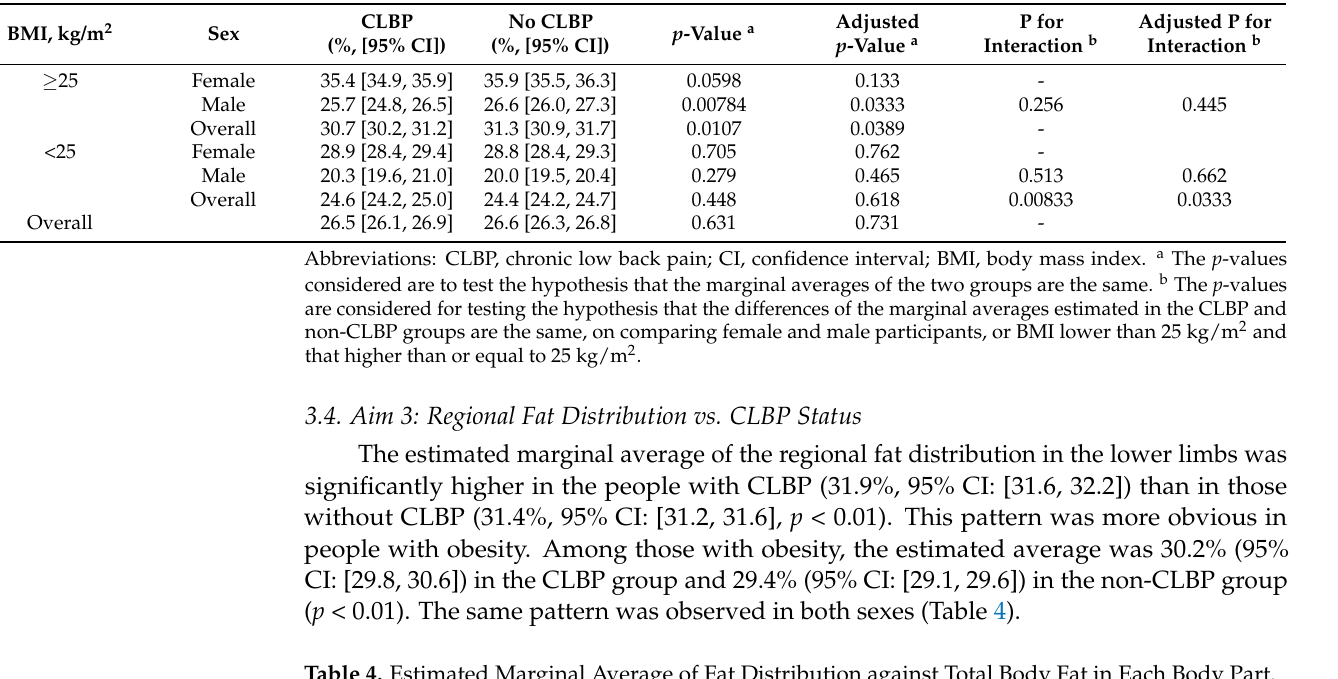
Table 4. Estimated Marginal Average of Fat Distribution against Total Body Fat in Each Body